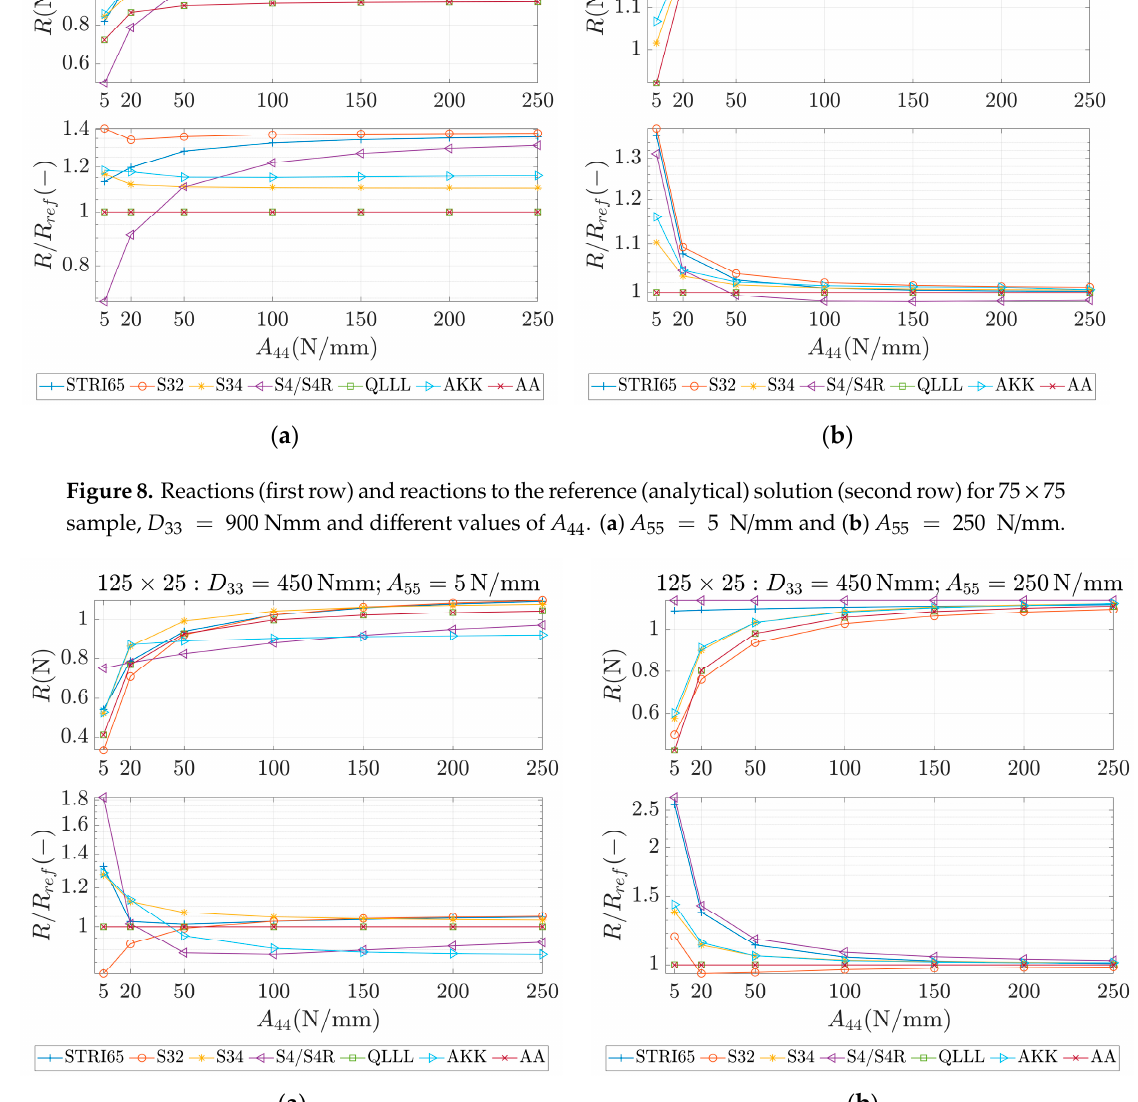
Figure 9. Reactions (first row) and reactions to the reference (analytical) solution (second row) for 125 × 25 sample, D 33 = 450 Nmm and di ff erent values of A 44 . ( a ) A 55 = 5 N / mm and ( b ) A 55 = 250 N /